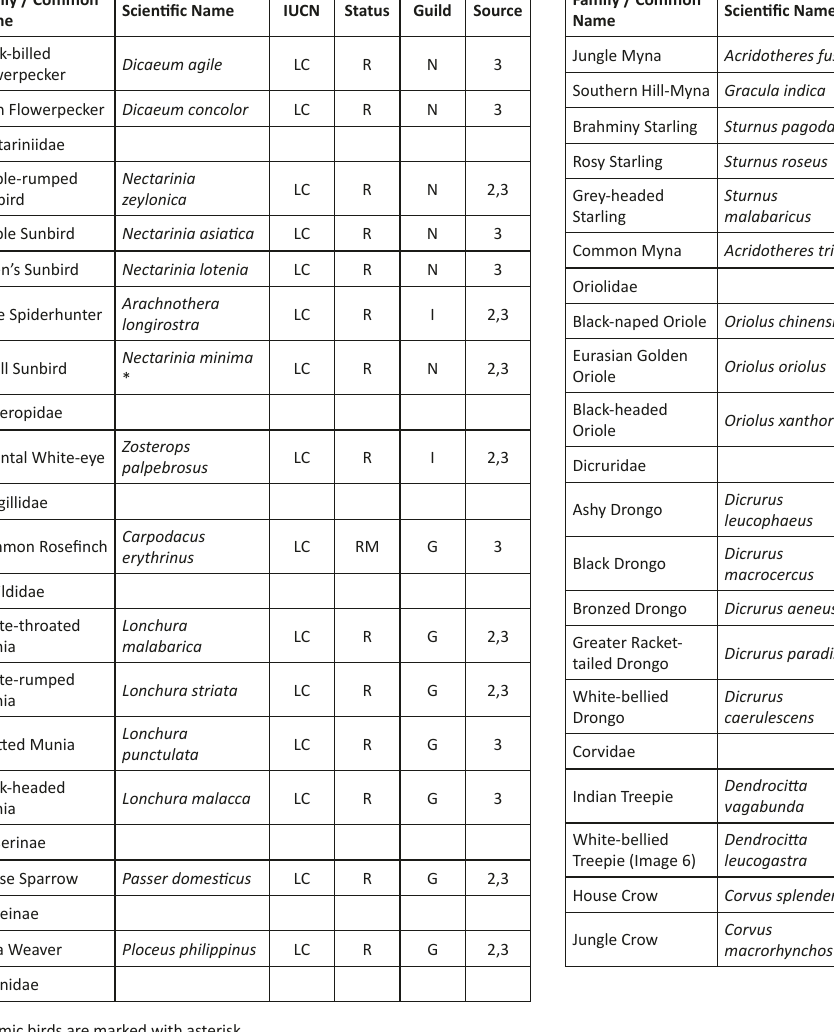
Endemic birds are marked with asterisk. IUCN Status: CR - Critically Endangered, EN - Endangered, VU - Vulnerable, NT - Near-threatened, LC - Least Concern Status: R - Resident, RM - Resident Migratory, M - Migratory Feeding guild: A - Aquatic vegetarians, G - Granivores, F - Frugivore, P - Piscivores, C - Carnivore (including carrion feeders), O - Omnivores, N - Nectarivores